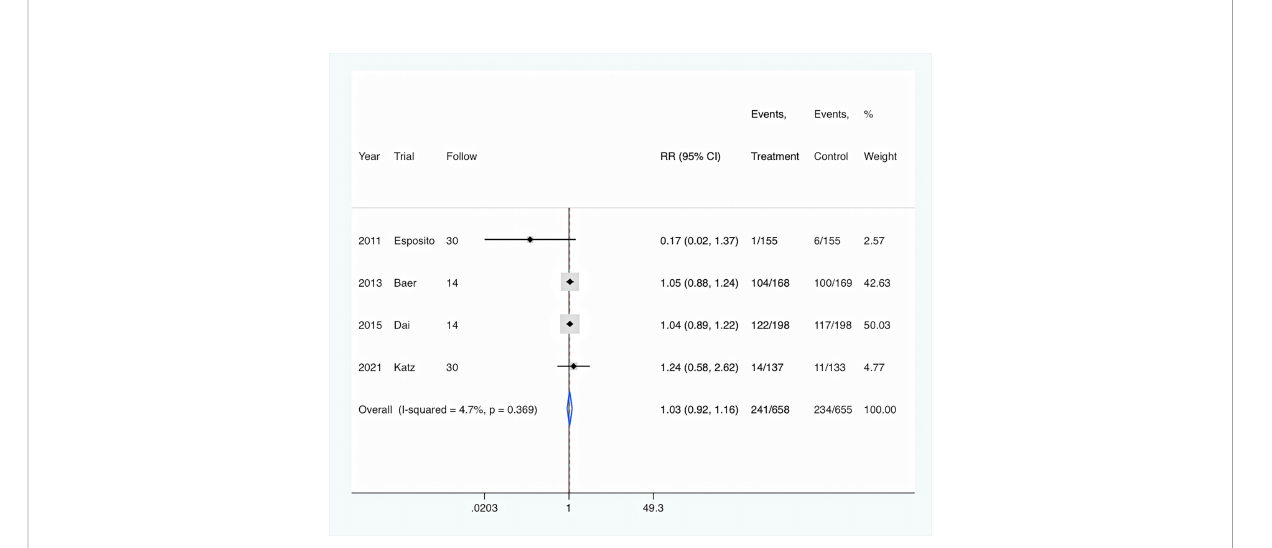
FIGURE 6 PCT-guided treatment was associated with similar rate of hospital